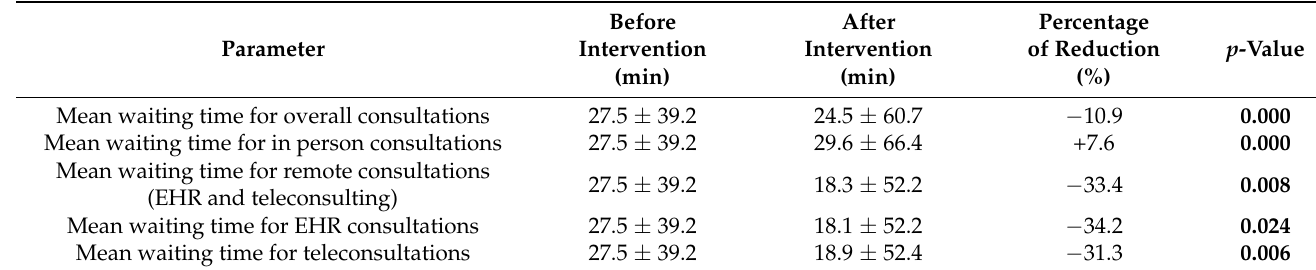
Table 2. Statistical comparison between the as-is and the to-be processes.